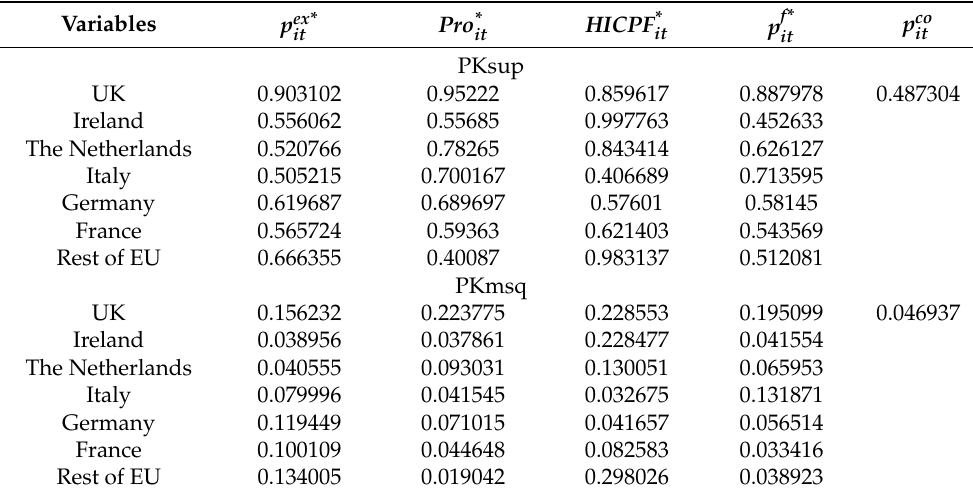
Table A3. Structural stability tests for extra-EU GVECM: statistics.